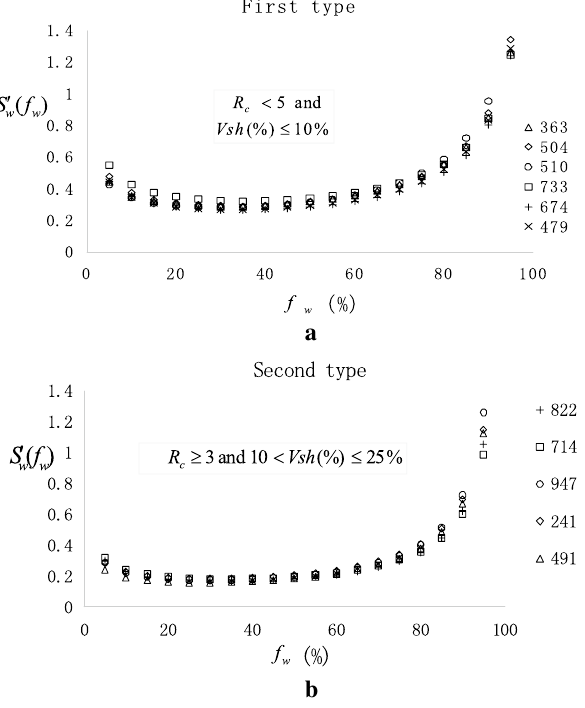
Fig. 6 a The correlation diagram between the water cutting rate and change rate of water saturation of samples in the first type group, b the correlation diagram between moisture content and change rate of water saturation of samples in the second type group, c the cor- relation diagram between moisture content and change rate of water saturation of samples in the third type group, d correlation diagram between the average water cutting rate and the average change rate of water saturation for individual